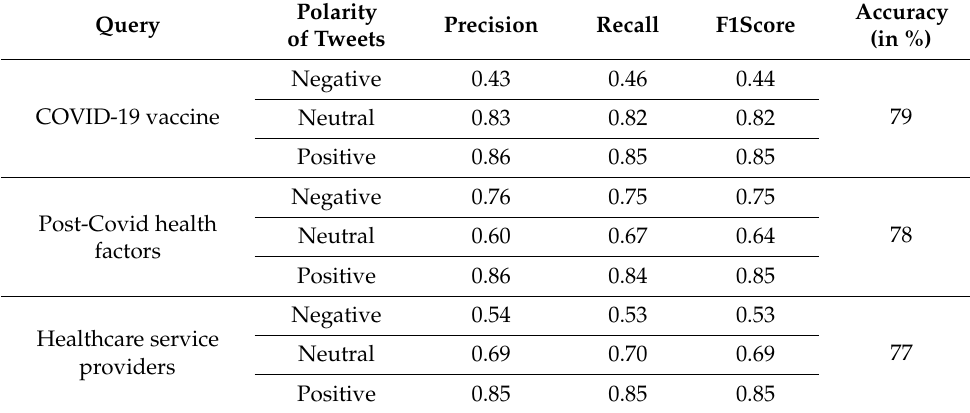
Table 5. Logistic regression model evaluation results for all three considered queries.